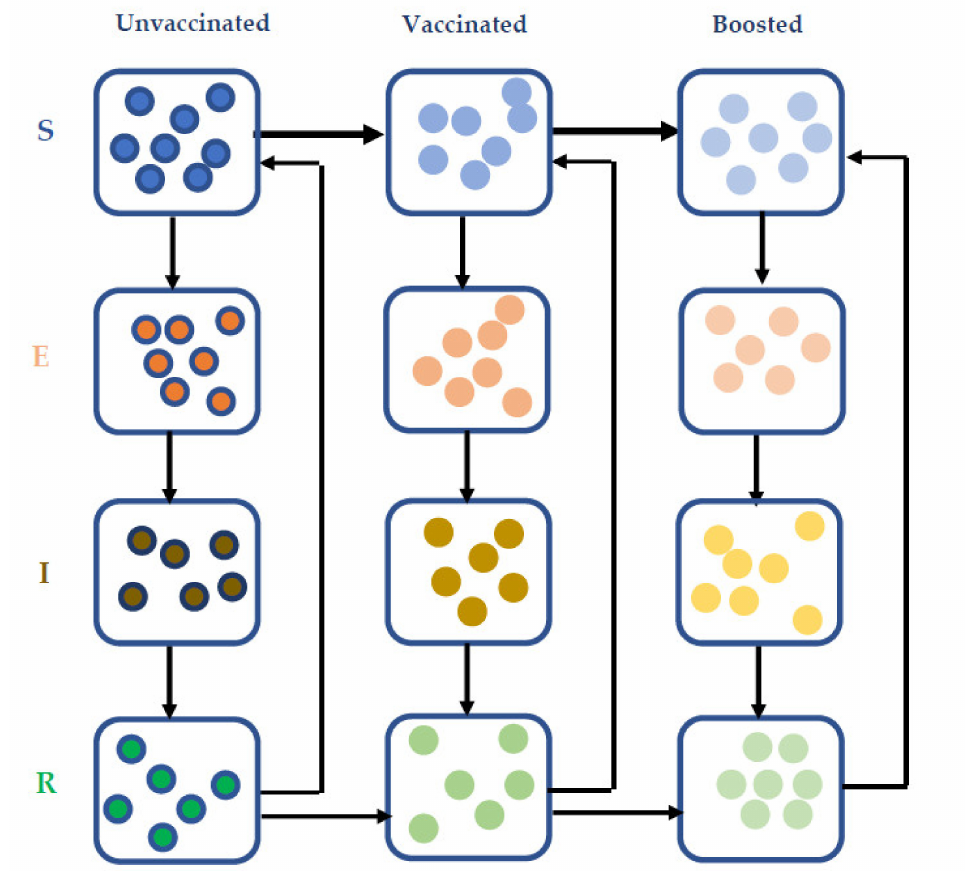
Figure 1. Model scheme for vaccinating